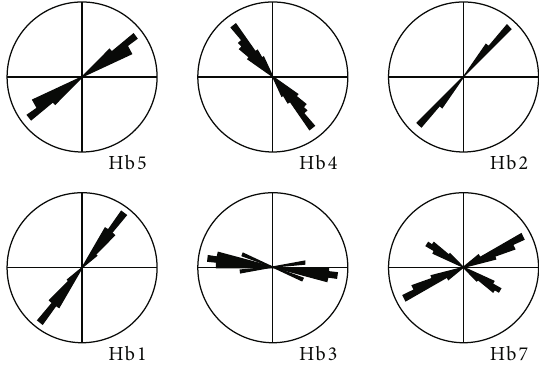
Figure 5: The S orientations interpreted from drilling-induced Hmax tensile fractures (DITFs) and wellbore breakouts (WBs) in the Haiba